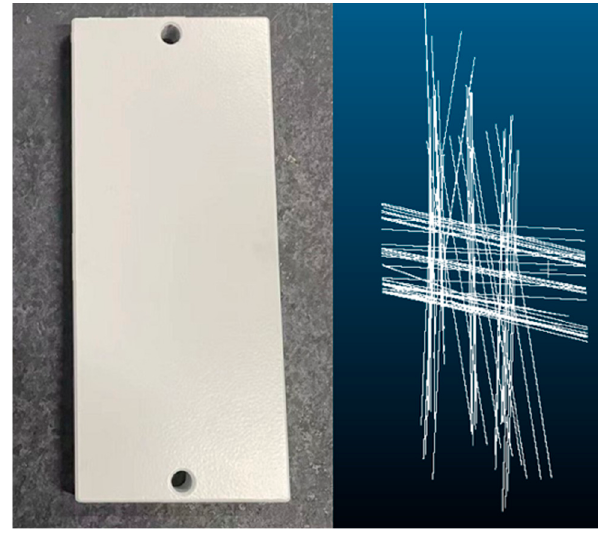
Figure 15. Flat board and the scanning result obtained.